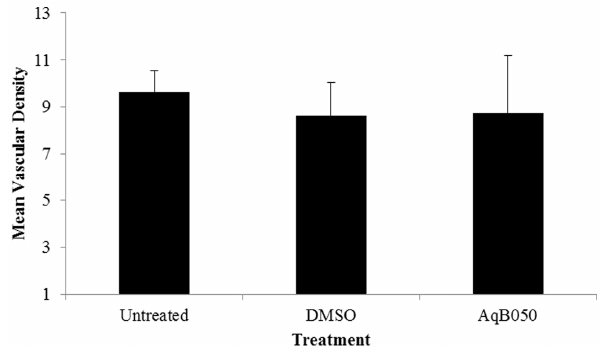
Figure 2. Mean microvessel counts in a MM xenograft model treated with AqB050. No difference in intratumoural vascular density per field was observed between untreated (range 8–12; n = 4), DMSO-treated (range 6–12; n = 4) and AqB050-treated (range 4–16; n = 4) groups in the in vivo mouse xenograft model. Analysed by one-way Analysis of variance (ANOVA), error bars: Standard error of mean (SEM).